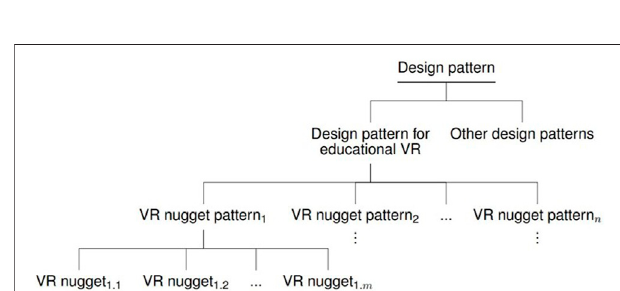
FIGURE 5 | The hierarchy graph shows the connection of VR nuggets andpatterns.Theterm VRnuggetpattern isusedinthisgraphtoillustratethat there may be design patterns for educational VR that are not suitable for VR nuggets, for example, when they are not self-contained or would not result in a concise VR